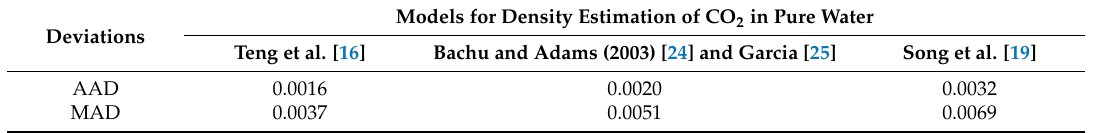
Table 4. Comparison of experimental data from this study with estimations from three different models for pure H 2 O saturated with CO 2